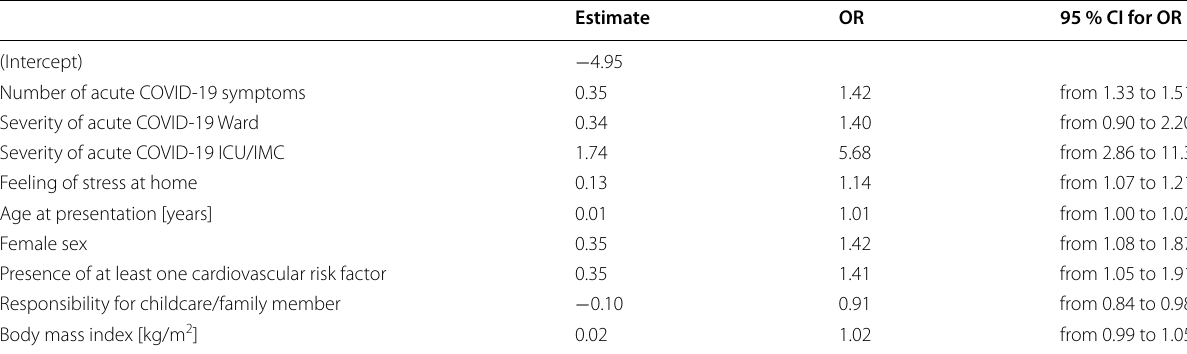
Table 2 Logistic regression model based on the ABE and ABESS variable selection, calculated on the derivation cohort